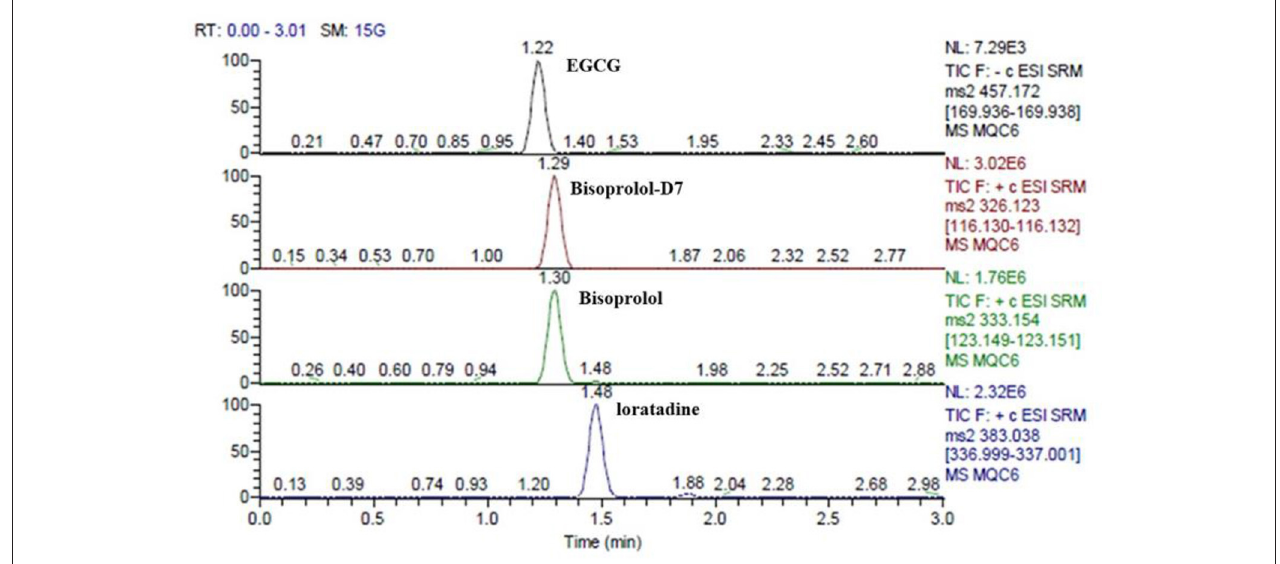
FIGURE 2 | The retention times of EGCG, bisoprolol, deuterated bisoprolol and loratadine in plasma sample at the same time.